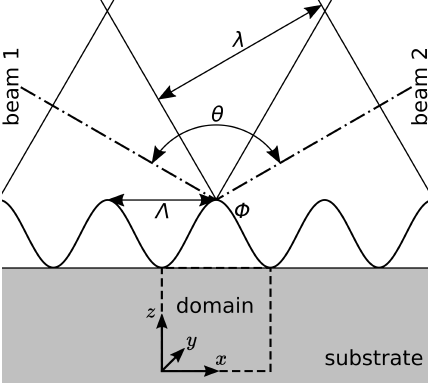
Figure 1. Two-beam interference scheme and computational